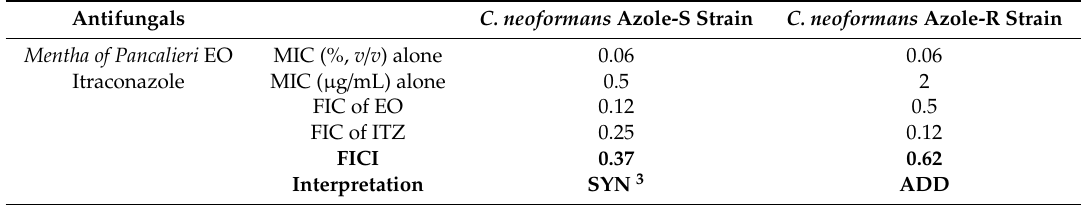
Table 5. MIC 1 and FICI 2 of the “Mentha of Pancalieri” EO plus itraconazole against azole-S/R Cryptococcus neoformans.